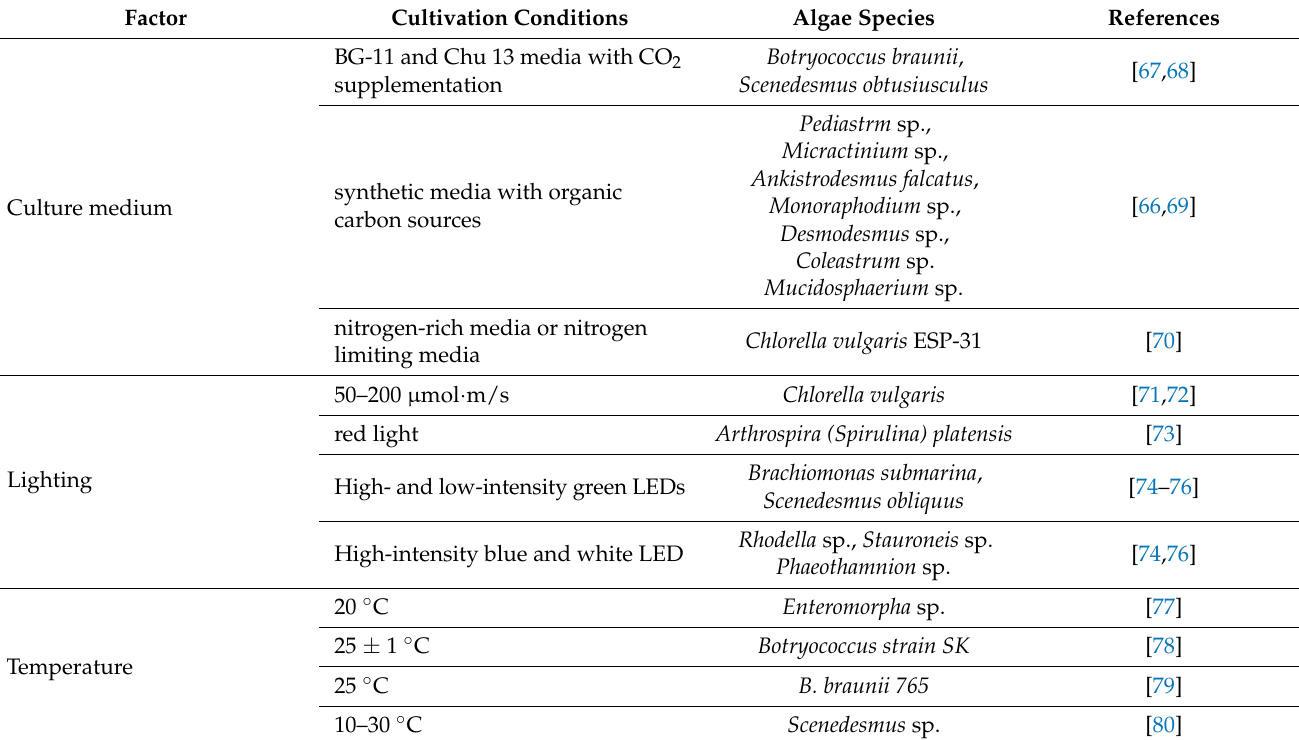
Table 2. Different types of algae cultures’ cultivation conditions depend on selected